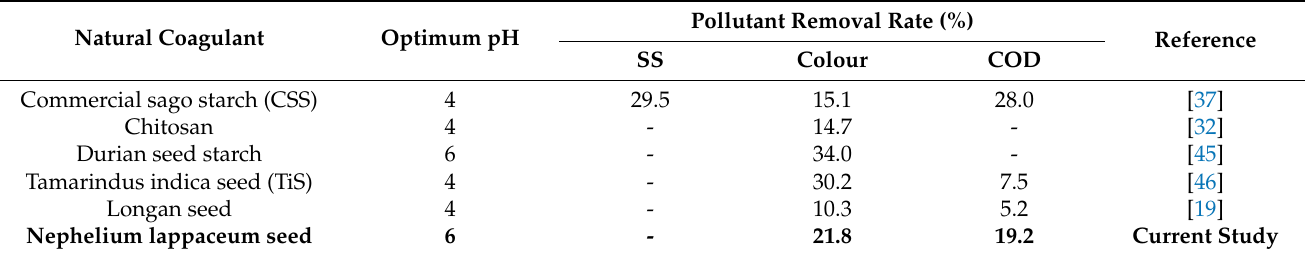
Figure 7. Effect of pH on pollutant removal using 1.5 g/L of Nephelium lappaceum seed dosage. Table 3. Comparison of previous and current studies for best pH values of various natural